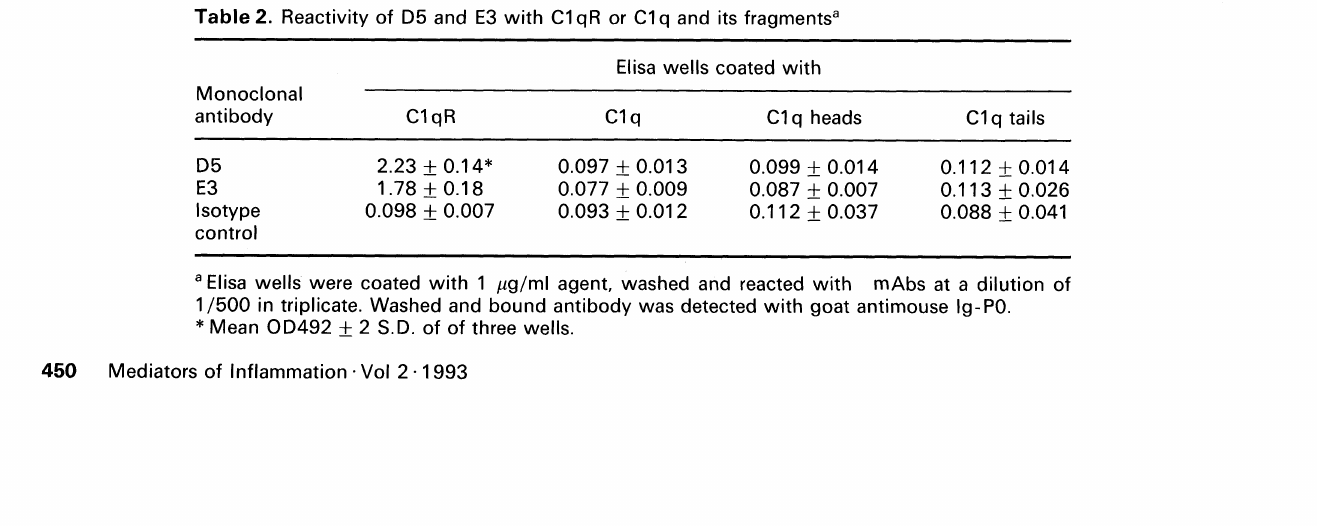
Elisa wells coated with